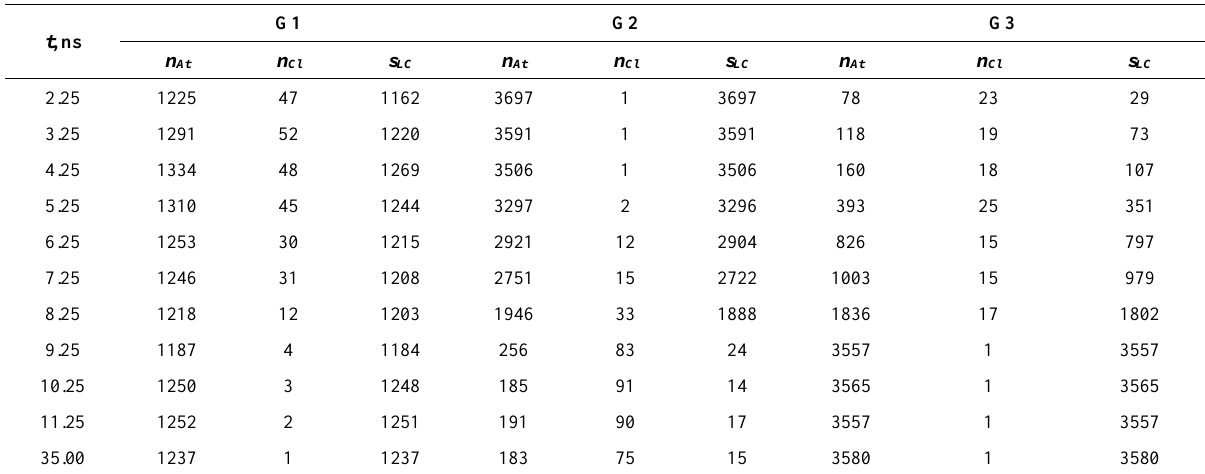
Table 1. Characteristics of atoms of different groups for 5000 atoms sample at 900 K. Here n At , n Cl and s LC is the number of atoms, number of cluster and size of largest cluster,